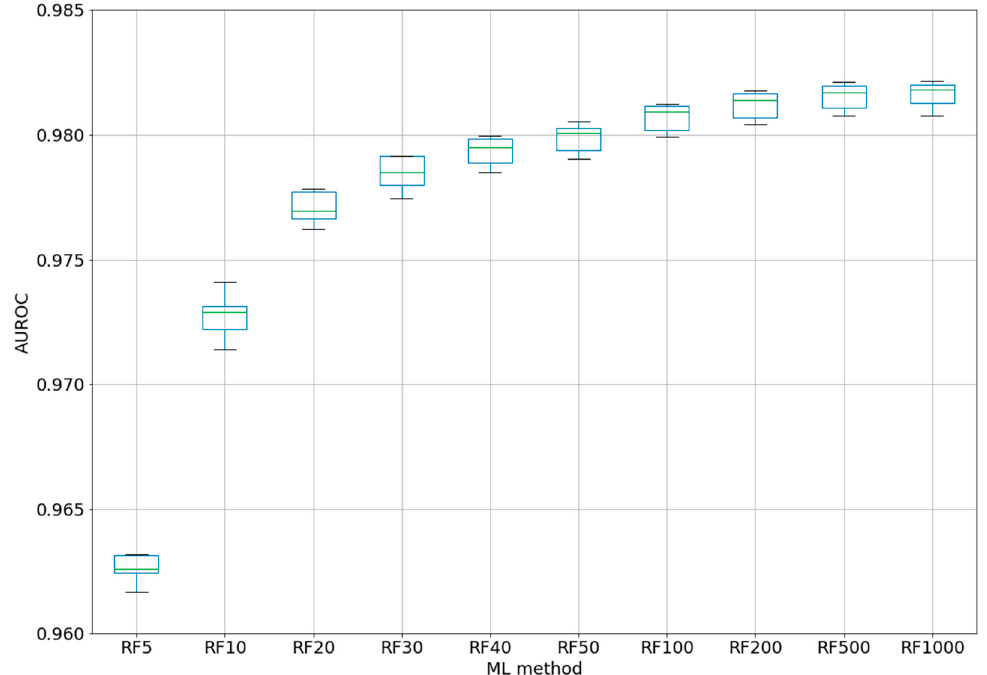
Figure 2. Box-plot for AUROC values of RF classifiers with different trees (five-fold CV). RF n = Random Forest with n trees ( n = 5, 10, 20, 30, 40, 50, 100, 200, 500, 1000).